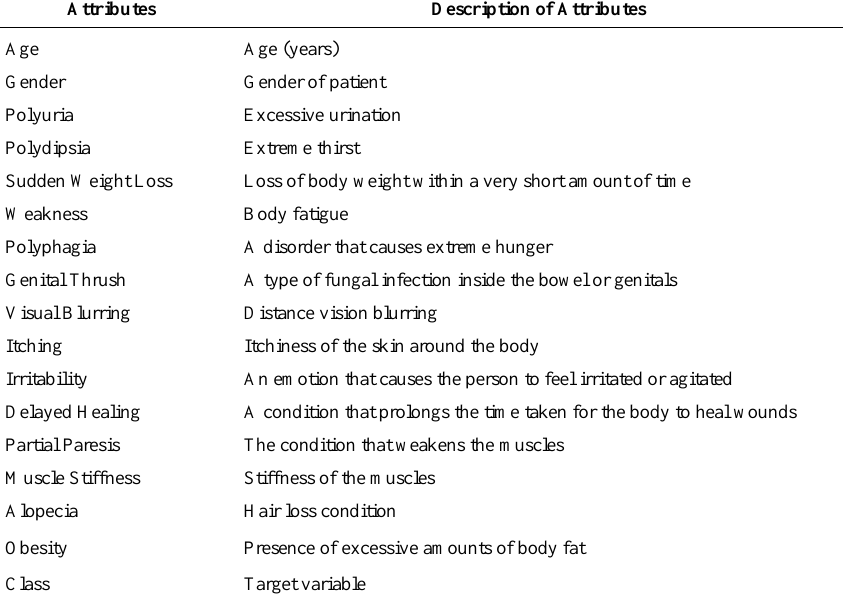
Table 2. Features of the early-stage diabetes